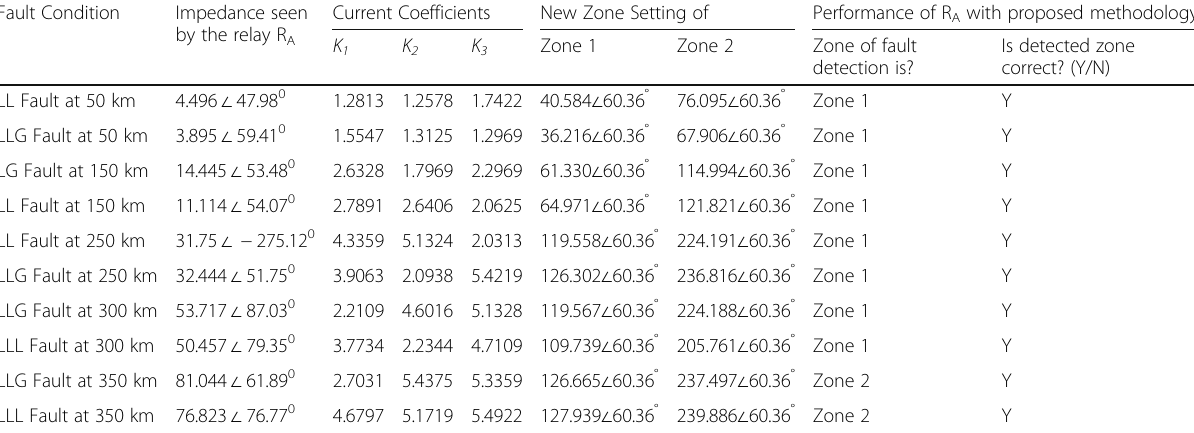
Table 8 Performance of distance relay R A with PAZSD methodology for different faults with FR = 1.7 Ω at different distances Fault